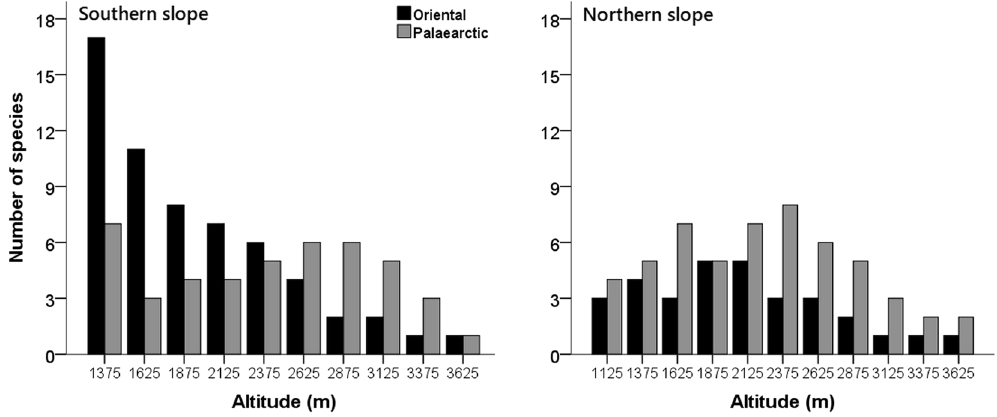
Figure 2. The elevational distribution of Oriental and Palaearctic rodent species (interpolated) along the southern and northern slopes of Mt. Taibai, China. The horizontal axis indicates the midpoints of the elevational